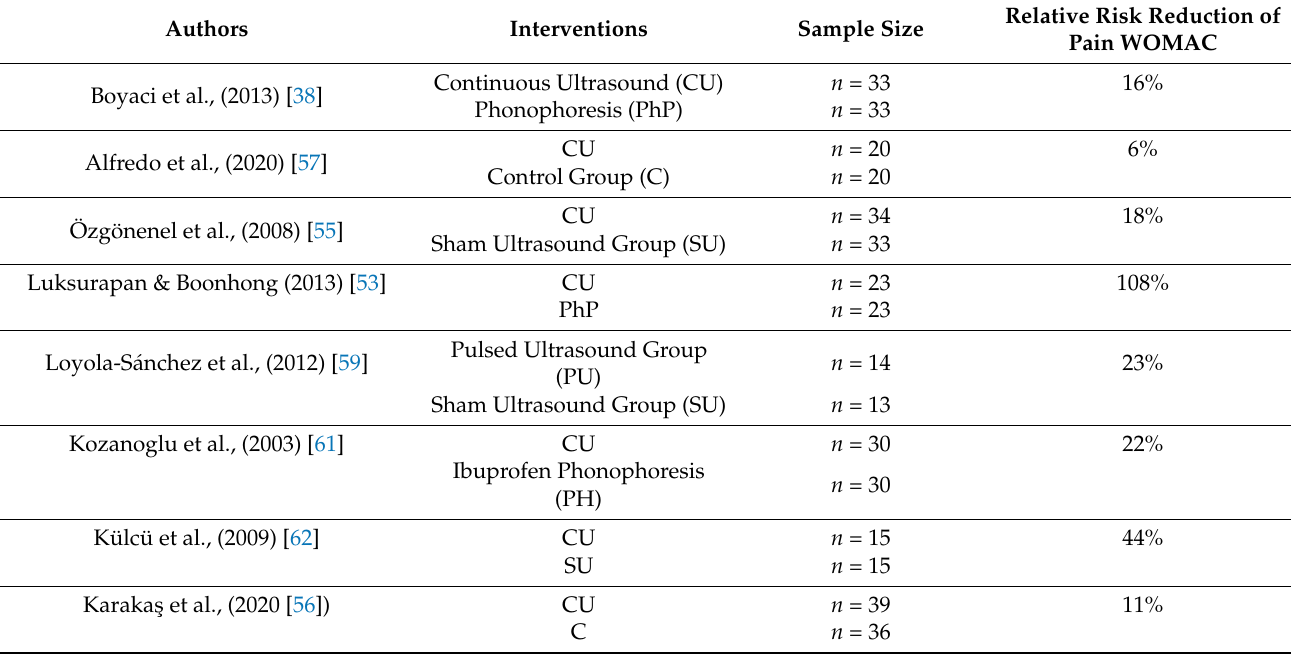
Table 3. Summary of the findings from the eight papers with interventions regarding ultrasound.